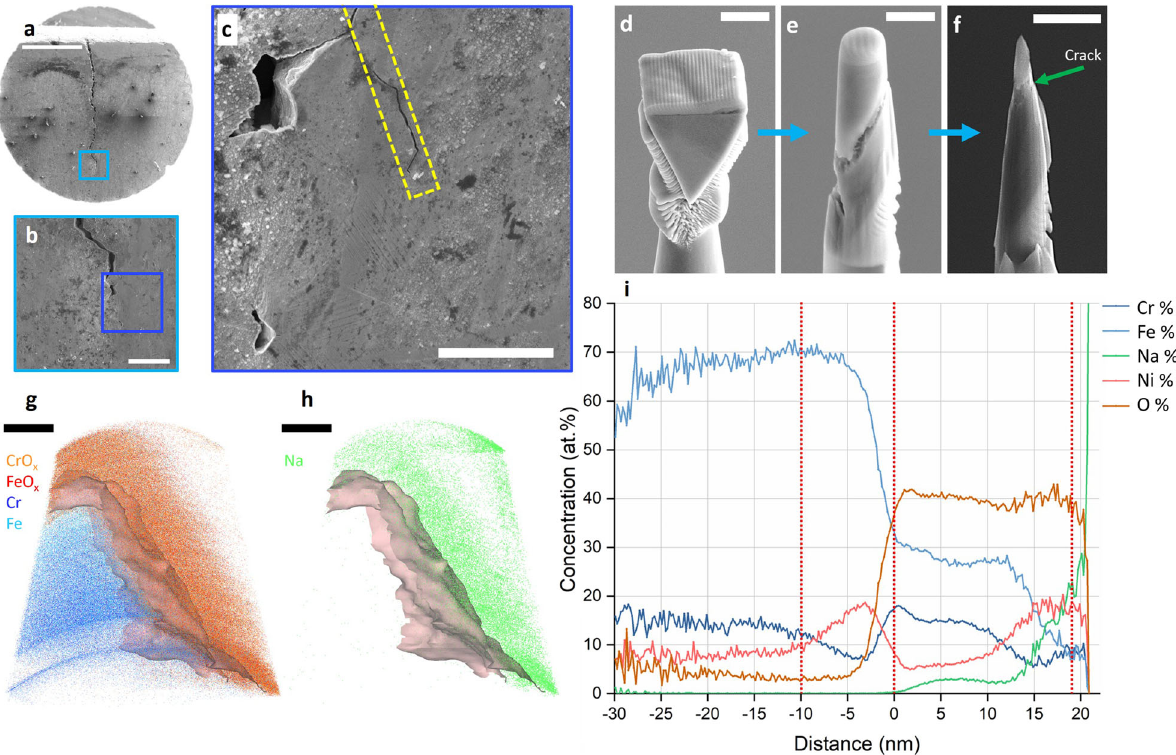
Fig. 5 Ex situ APT measurements of IGSCC. Secondary electron images showing: ( a ) An arrested crack in a sample following failure by IGSCC (scale bar: 500 µm), ( b ) a higher magni fi cation image of the region outlined in light blue in ( a ) (scale bar: 50 µm), ( c ) a higher magni fi cation image of the region outlined in dark blue in ( b ) with the region of APT analysis outlined by a dotted yellow box (scale bar: 20 µm), ( d ) a segment of the area outlined in yellow in (c) mounted onto an APT grid (scale bar: 2 µm), ( e ) an intermediate needle following FIB thinning (scale bar: 1 µm), and ( f ) the fi nal APT needle seen to contain a section of the crack with the crack running diagonally across as indicated (scale bar: 1 µm). Also shown are 3D APT reconstructions containing a 37 at.% oxygen iso-concentration surface with: ( g ) CrO x , FeO x , Cr and Fe ions (scale bar: 10 nm), and ( h ) (2× size) Na ions (scale bar: 10 nm). i Shows a deconvoluted proximity histogram showing the concentration pro fi le either side of the 37 at.% oxygen iso-concentration surface shown in ( g ) and ( h ), red dotted lines indicate boundaries between compositionally differing regions. An additional version of ( i ) with error bars is given in Supplementary Fig.